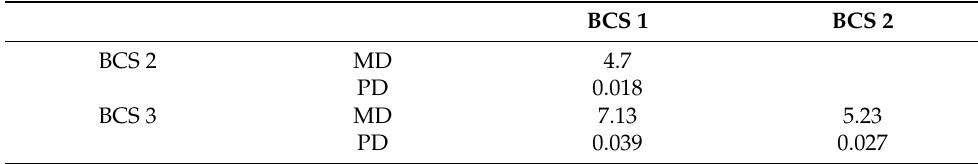
Figure 10. Average observations of the donkeys’ dorsal profiles grouped by body dental condition score (DCS 0, DCS 1, and DCS 2) and represented by ( A ) wireframe graphs and ( B ) a transformation grid. In the wireframe graphs, light blue landmarks and curves represent the consensus donkey’s dorsal profile and the dark blue landmarks and curves represent the average observations for the subsequent DCS scores. On the transformation grid, dark blue landmarks represent the consensus donkey’s dorsal profile and the dark blue lines represent the average observations for the subsequent DCS scores. Dashed lines indicate the boundaries between regions. Consecutive landmarks are marked with increasing numbers from the first caudalis vertebra (1) to the tuber faciale (30). Table 2. Mahalanobis distances (MD) and Procrustes distances (PD) among the body condition score (BCS) categories (BCS 1, BCS 2, and BCS 3).